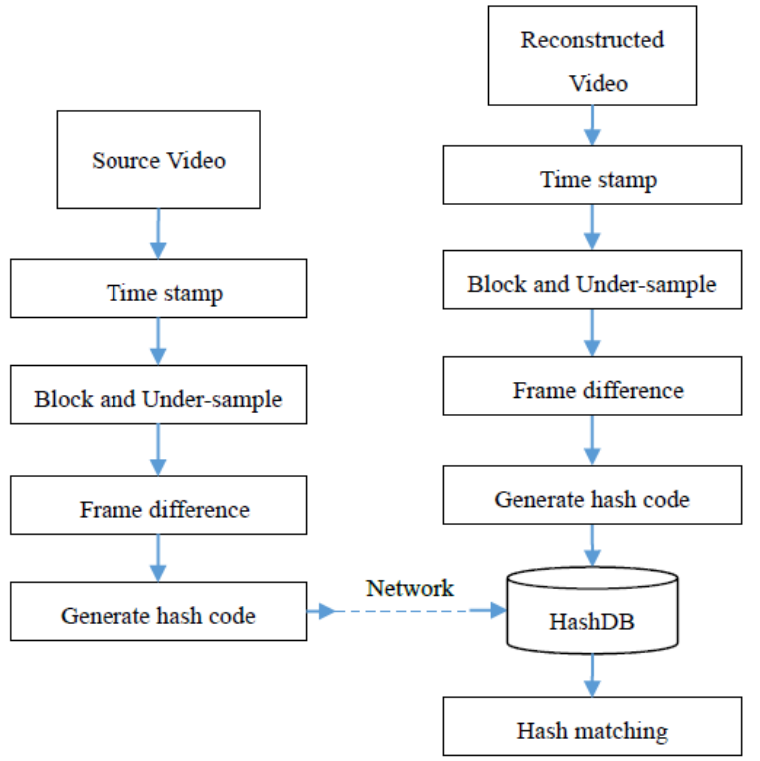
Figure 6. Lossless remote video delay measurement algorithm.